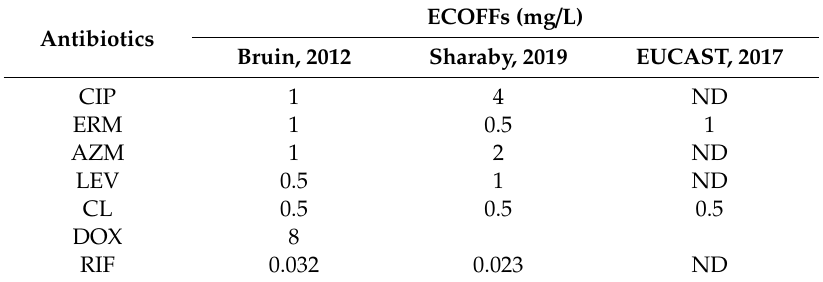
Table 3. Epidemiological Cut-O ff (ECOFF) values proposed by European Society of Clinical Microbiology and Infectious Diseases (EUCAST) [32]; Bruin et al. (2012) [29] and Sharaby et al. (2019) [30]. ECOFFs (mg / L) Antibiotics Bruin, 2012 Sharaby, 2019 EUCAST, 2017 CIP 1 4 ND ERM 1 0.5 1 AZM 2 ND LEV 0.5 1 ND CL 0.5 0.5 0.5 DOX RIF 0.032 0.023